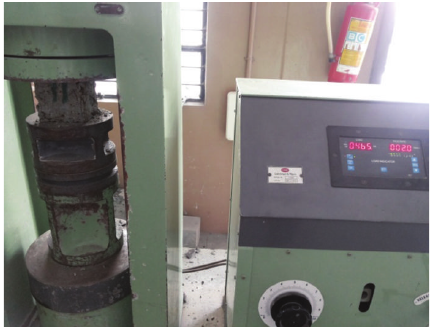
Figure5:Compressivestrengthofconcreteforalternatewettingand drying of concrete specimens in chloride-free water (stressed at 40% ultimate load).